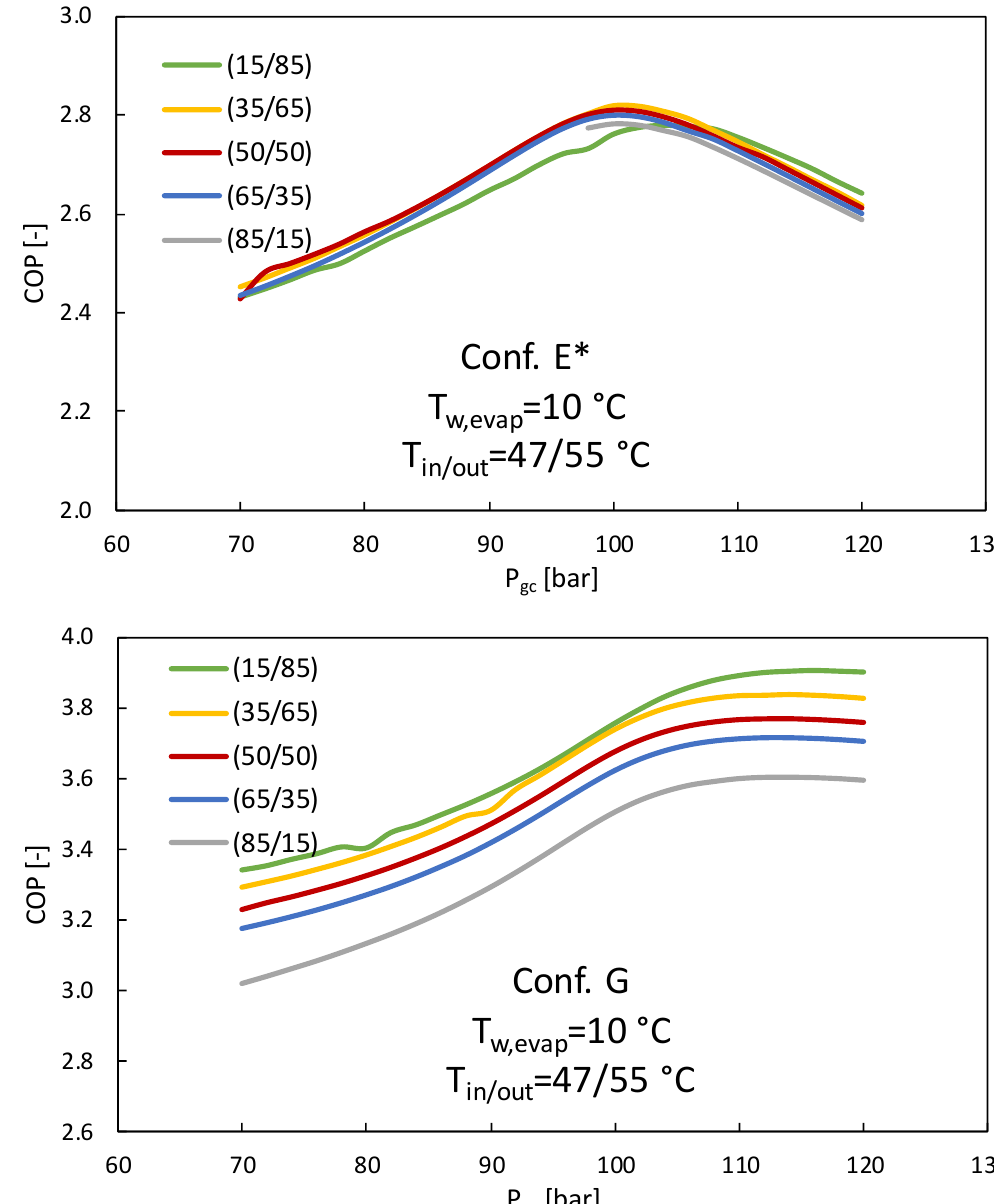
Figure 9. Influence of the ratio of the heating water sent to the DMS condenser and gas cooler on the COP of the system for configurations Conf. E* ( up ) and Conf. G ( down ).